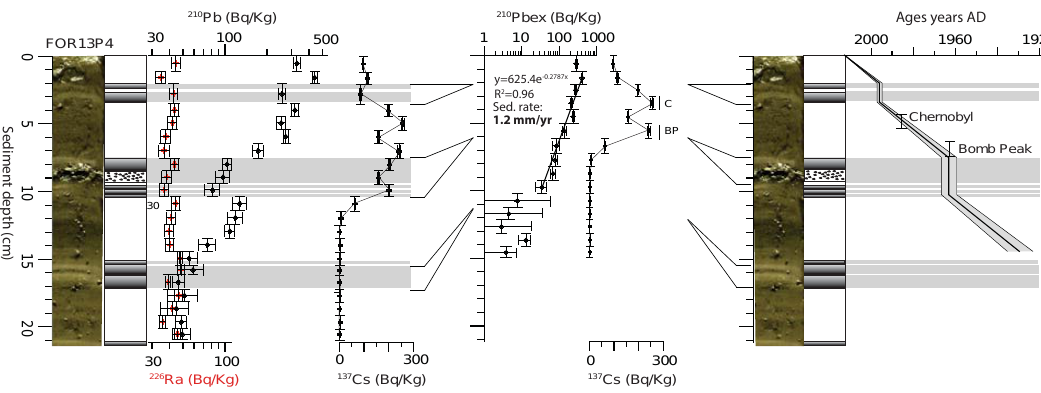
Figure 4. (a) 226 Ra, 210 Pb and 137 Cs profiles for core ALO09P12. (b) Application of a CFCS model to the event-free sedimentary profile of 210 Pb in excess (without the thick graded beds considered as instantaneous deposits). (c) Resulting age–depth relationship with 1 σ uncer- tainties and locations of the historic 137 Cs peaks supporting the 210 Pb-based ages. C corresponds to the historic 137 Cs peak of Chernobyl (AD 1986) and MP to the maximum 137 Cs peak of the nuclear fallout (AD